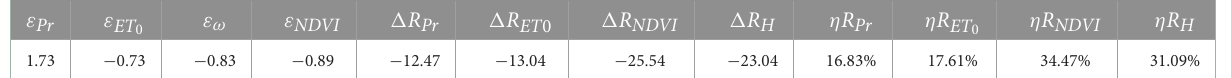
TABLE 2 Attribution analysis of streamflow variation in the Lancang River Basin (LCRB). ε Pr ε ET